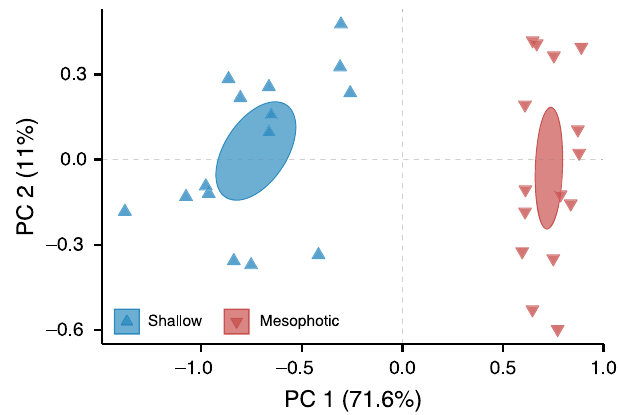
Fig. 4 Principal coordinates analysis (PCoA) of the morphological characters of S. pistillata based on Euclidean space. Each color and shape represents a particular colony at a given depth ( n = 30). Ellipses represent